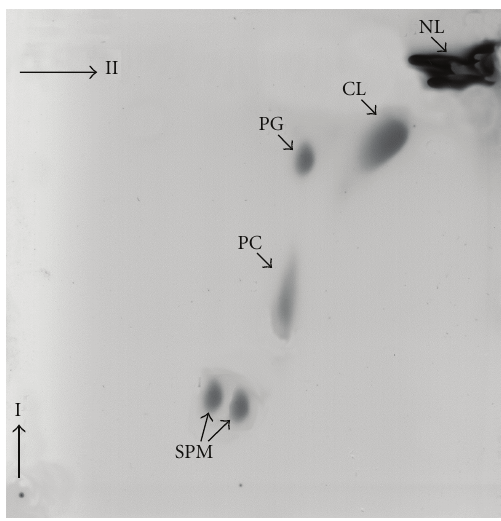
Figure 1: The major polar lipids of M. hyorhinis. Lipids were extracted from membrane preparations by the method of Bligh and Dyer [18]. The lipids were separated by TLC on silica gel plates (Kiesel-gel 60HR, Merck, Darmstadt, Germany) developed at room temperature by a two-dimensional system using chloroform- methanol-ammonia (65:35 :4 by vol.) for the first dimension and chloroform-methanol-acetic acid-water (85: 25:5: 4 by vol.) for the second dimension. Lipid spots were detected by iodine vapor, while phospholipid spots were detected by the molybdate spray reagent [29]. The spots were tentatively identified based on their comigration with commercial standards as NL, neutral lipids; CL, cardiolipin; PG, phosphatidylglycerol; PC, phosphatidylcholine; SPM,